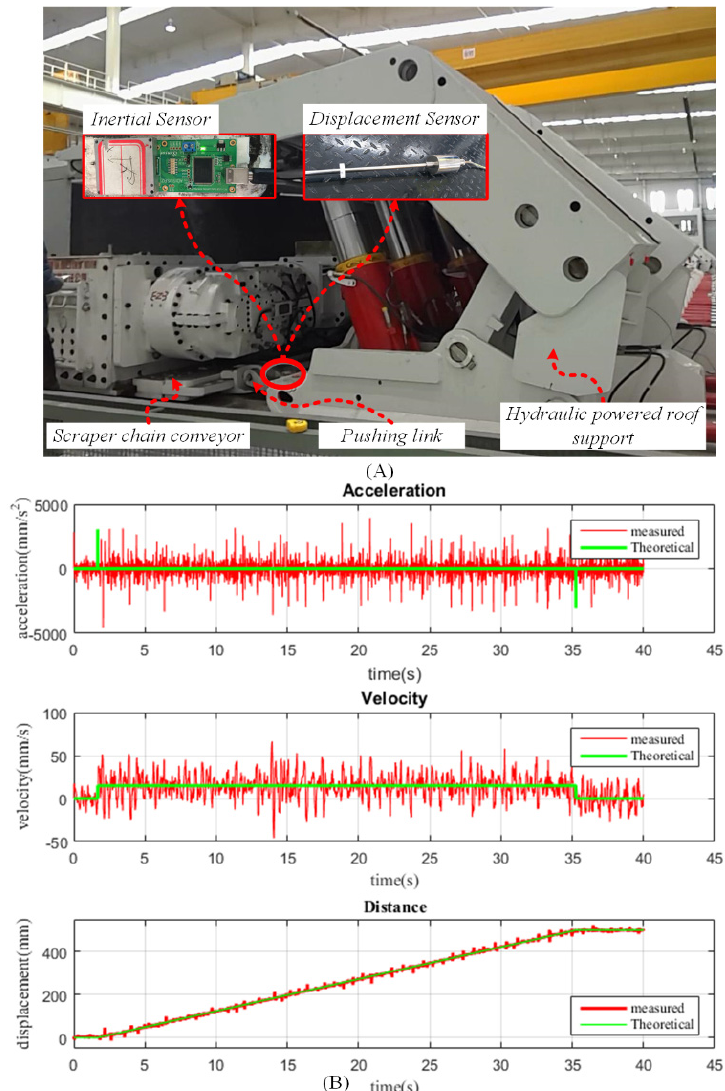
Figure 9. Experiment configuration and data collection. ( A ) The sensor installation on the hydraulic powered roof support; and ( B ) the theoretical data and measured data.